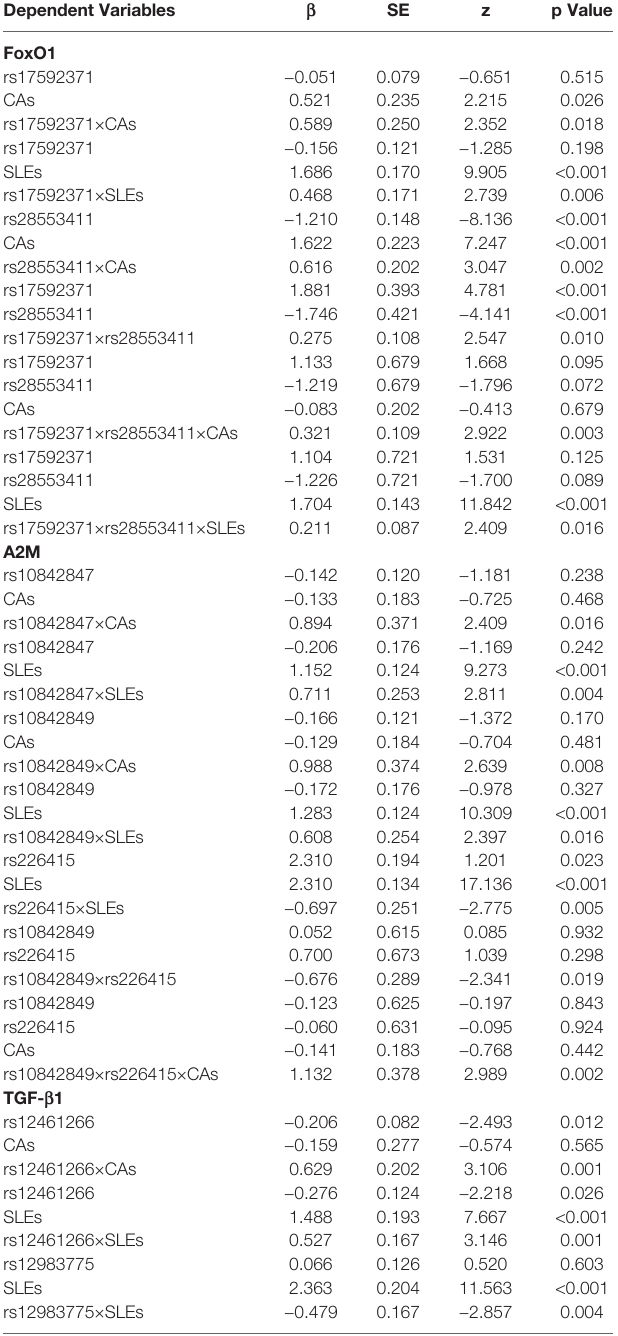
TABLE 3 | Effect of Candidate Genes, Environment, and Their Interaction on MDD. Dependent